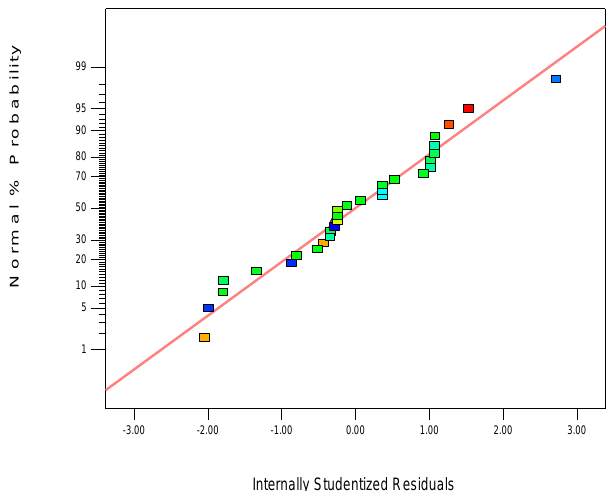
Figure 3. Residuals plot for CS. Figure 3 Residuals plot for CS Figure 3 Residuals plot for CS